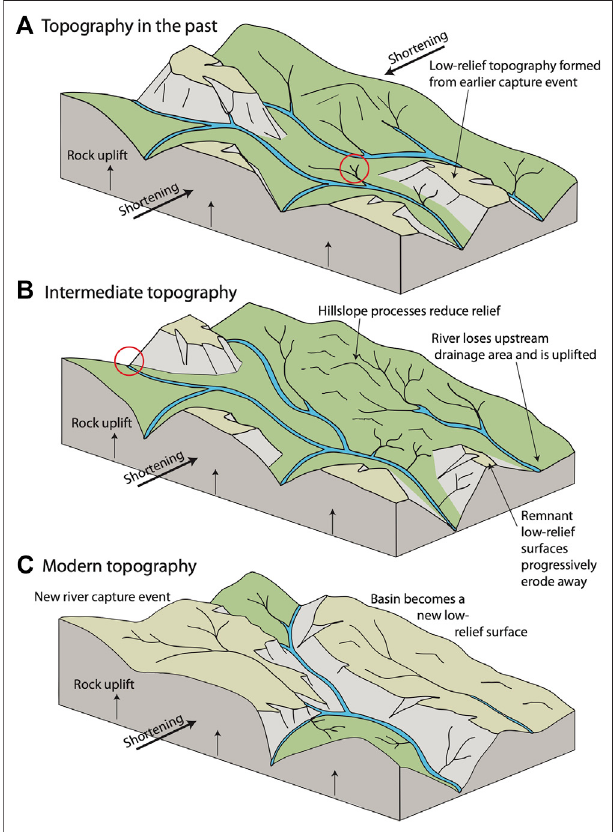
FIGURE 2 | Hypothesis 2. (A) After a topography had developed across SE Tibet, Hypothesis 2 proposes there would have been some low-relief landscapes due to drainage reorganization. (B) During ongoing drainage reorganization driven by shortening perpendicular to major rivers, the tributary circled in (A) captures the upper river. The associated loss in upstreamdrainageareareducestheerosionrateoftheriverleadingtosurface uplift. Hillslope processes continue to erode hillslopes however the river has lost the ability to incise, leading to a reduction in topographic relief. Low-relief surfaces from previous capture events are eaten away by erosion. (C) The basin that lost upstream drainage area continues to have less and less relief and iseaten awaybyerosion.Acaptureeventupstream ofthe redcircle in (B) leads to the beginning of new low-relief topography. This process is continuous and leads to the lowest-relief landscape being preserved for short amounts of time at the highest elevations. Therefore, the modern topography reveals a snapshot of this process and patches of low-relief landscape at high elevations are not remnant of a pervasive low-relief landscape.